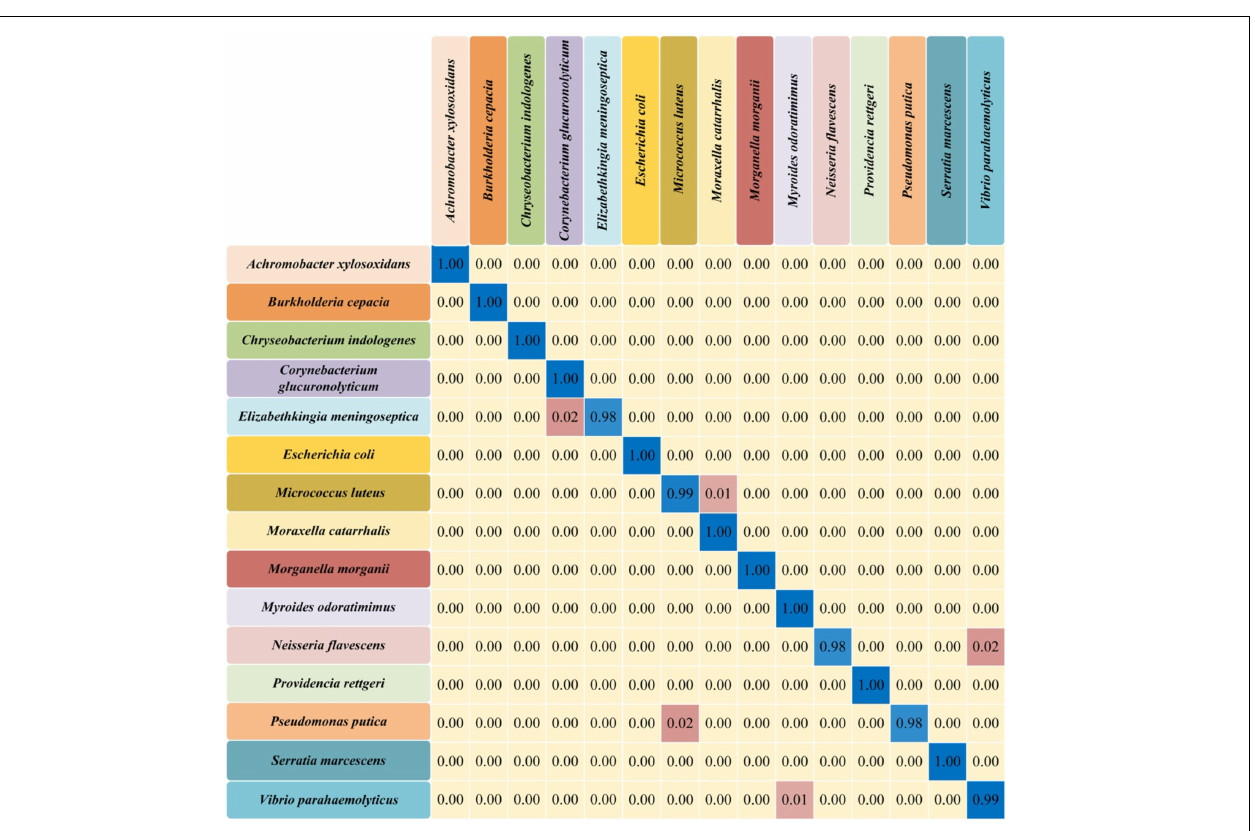
FIGURE 5 | Confusion matrix of the convolutional neural network (CNN) model for 15 different bacterial pathogens. The rows in the confusion matrix represented the true categories of predictions, while the columns represented the categories of the incorrect predictions. The probability of correct prediction (diagonal) and the probability of incorrect prediction (off-diagonal) were all present in the matrix.